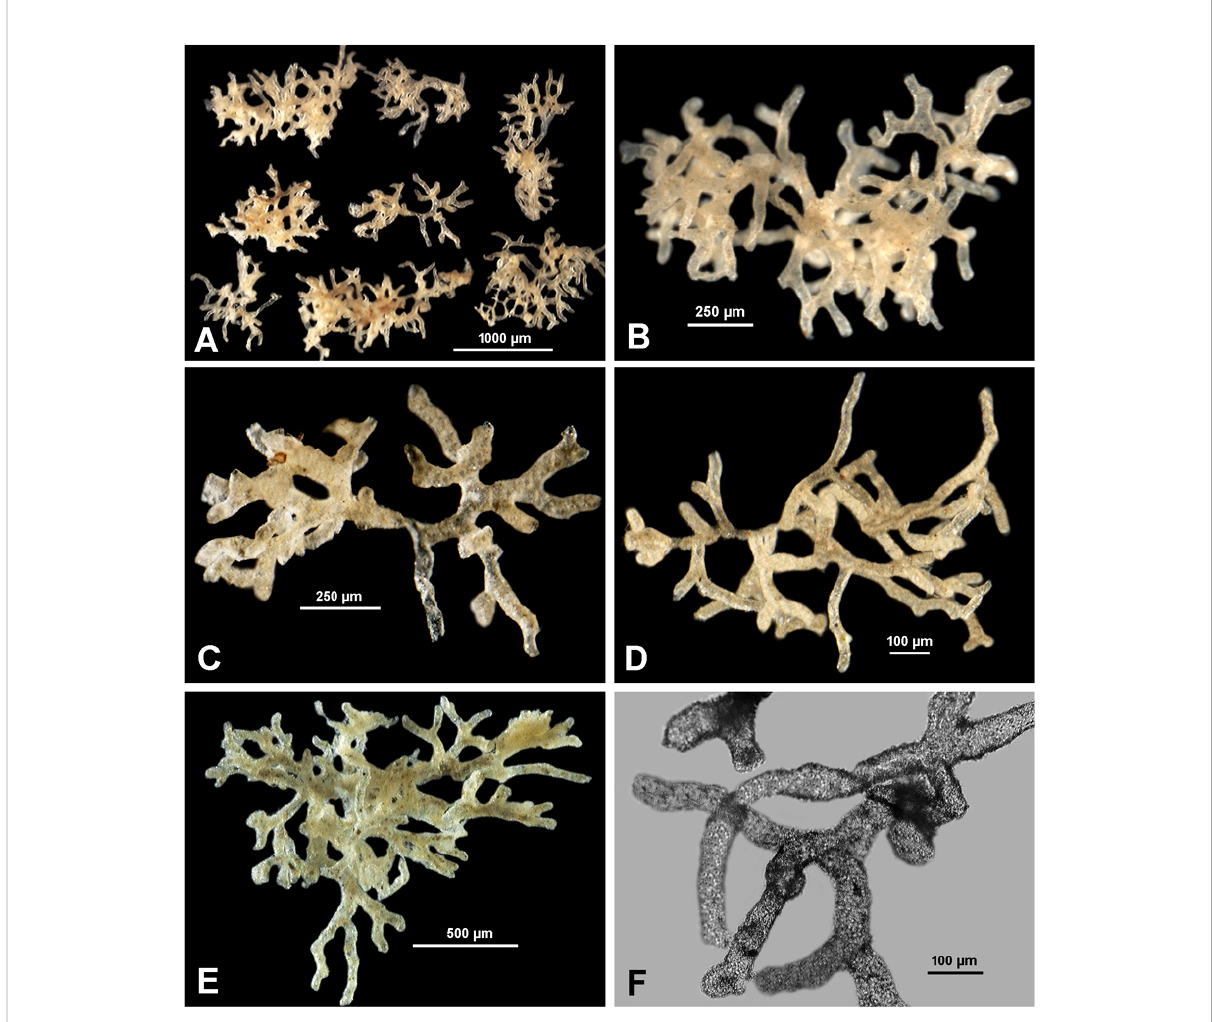
FIGURE 5 Indeterminate Komokiidae from APEI-3. (A – D) Sample 210. (E, F) Same species from Sample